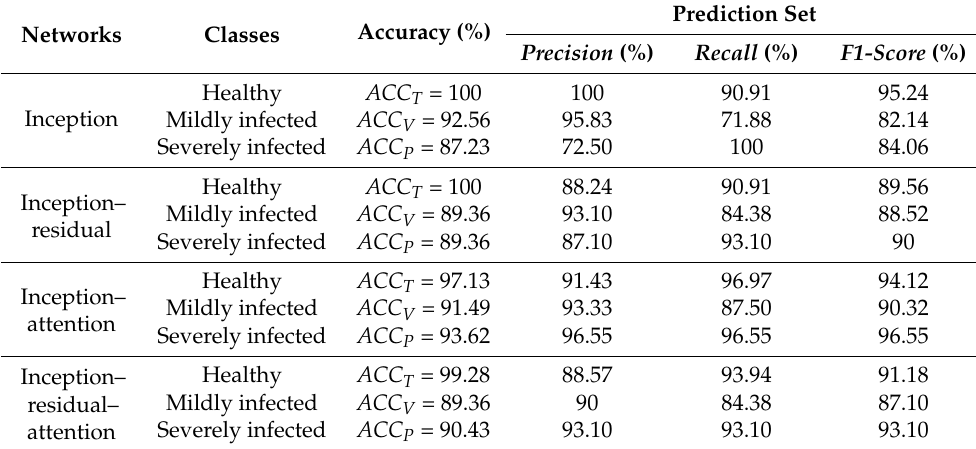
Table 3. Classification of FHB-infected wheat kernels using Inception, Inception–residual, Inception– attention and Inception–residual–attention